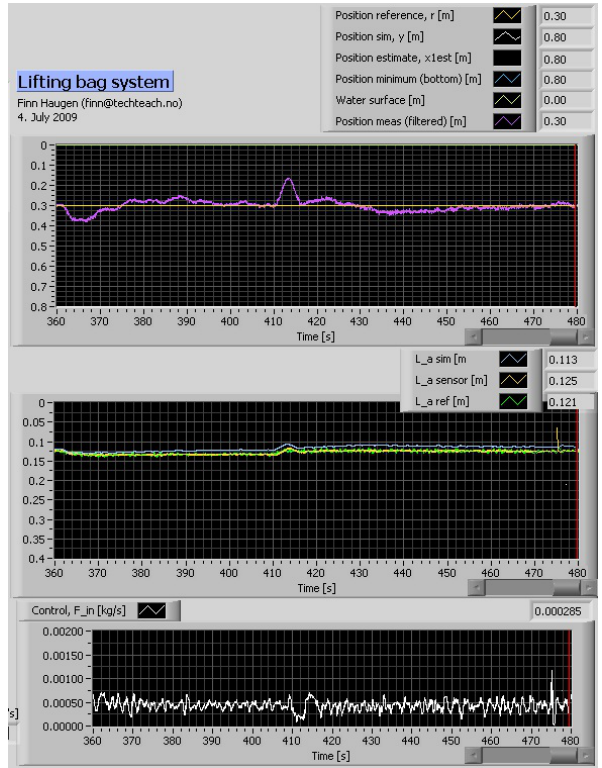
Figure 9: Cascade control with feedforward from esti- mated load force: A load mass of 0.5 kg was added at time 360 s, and then removed at time 410